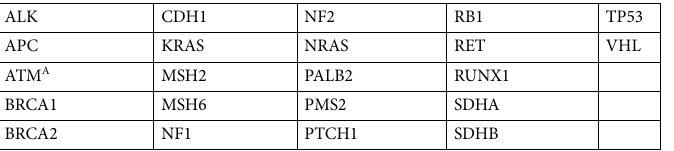
Table 1. List of sequenced autosomal dominant predisposition genes. A ATM found to be biallelic pathogenic variant by Zhang et